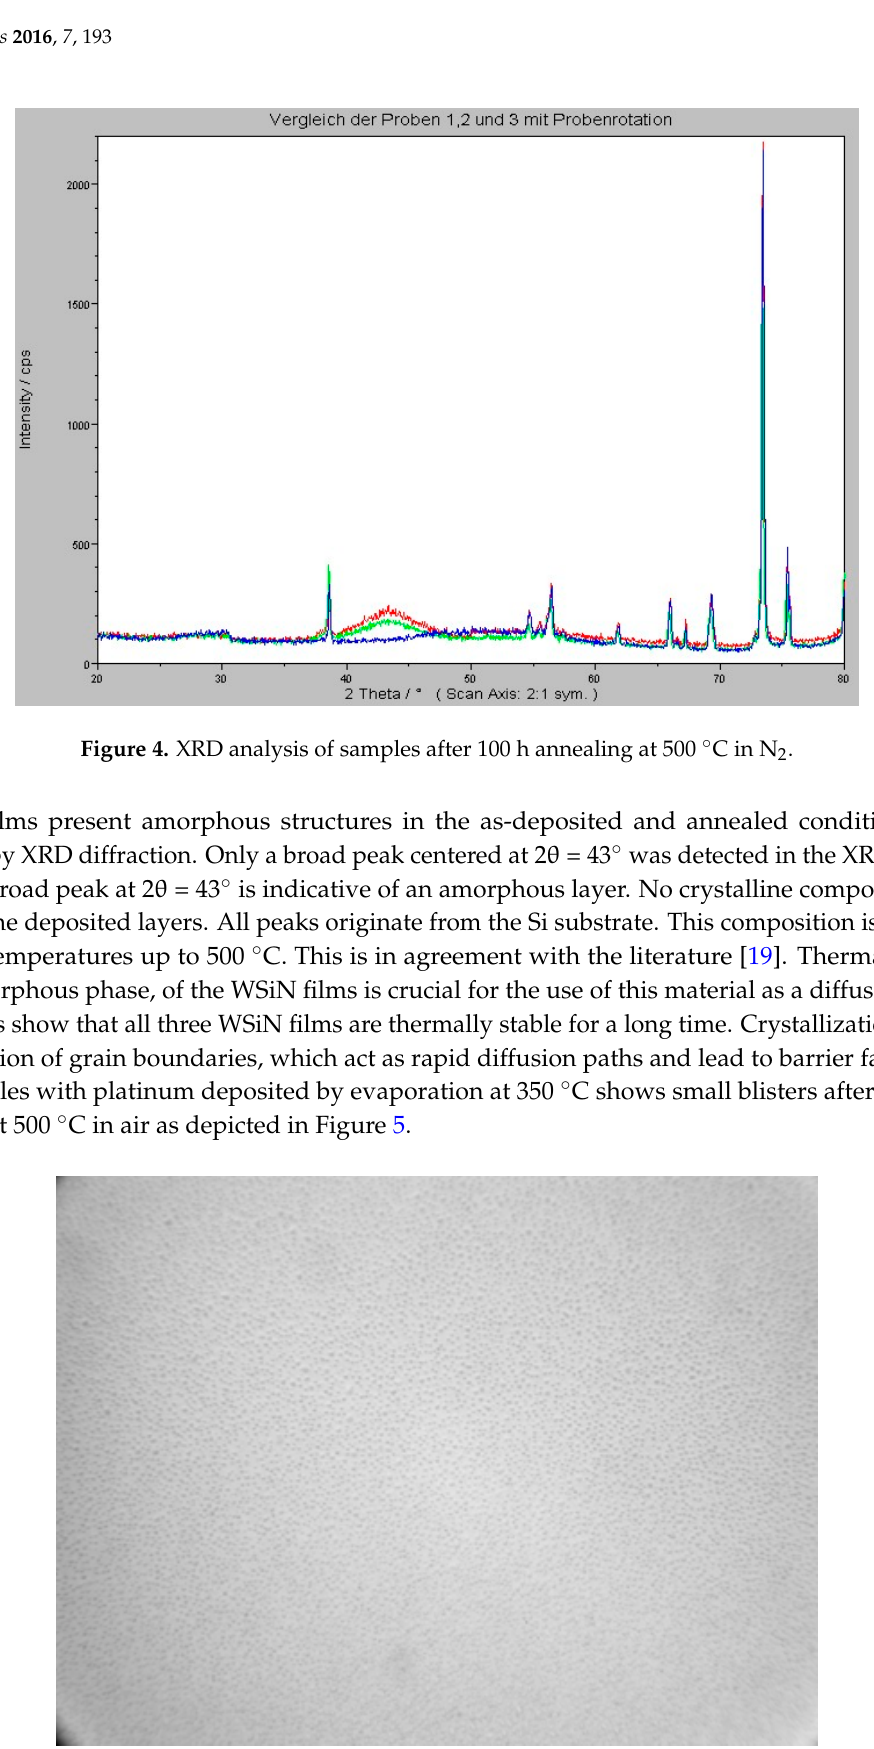
Figure 5. WSi–WSiN–Pt metallization after 100 h of annealing at 500 °C in air (magnification 500×).